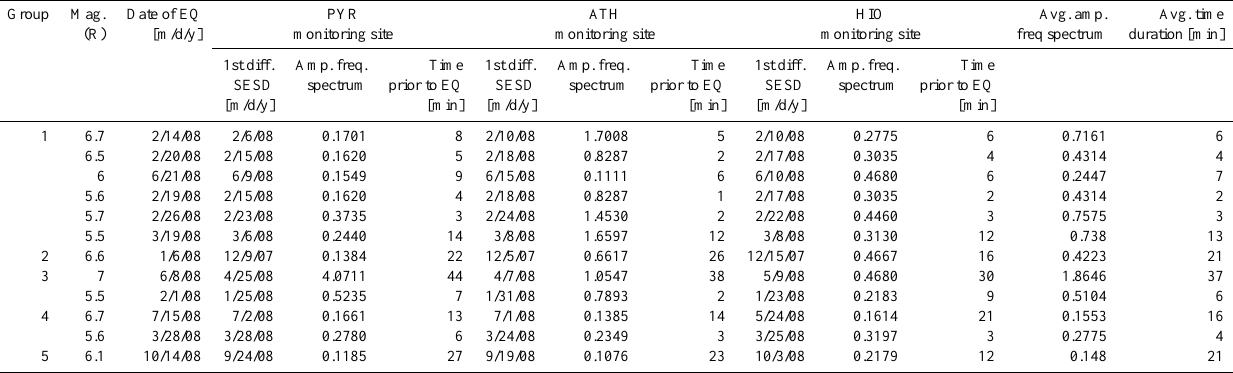
Table 3. The classification of data based on the location. Group Mag. Date of EQ PYR ATH HIO Avg.